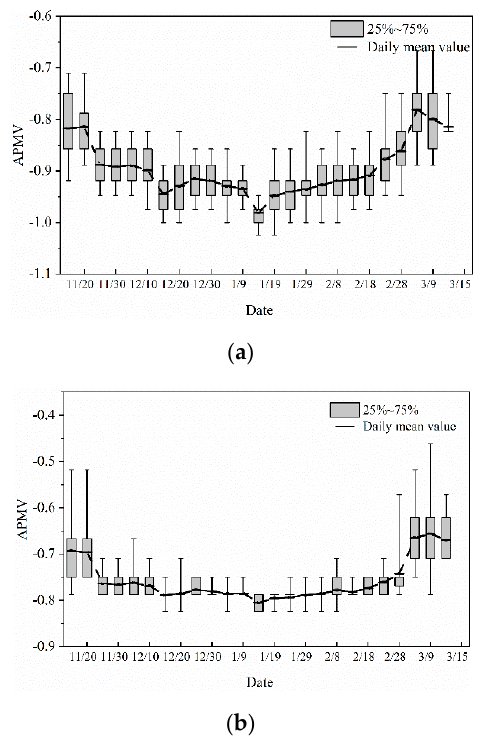
Figure 3. PMV in the study room during heating season: ( a ) original building and ( b ) standard building.